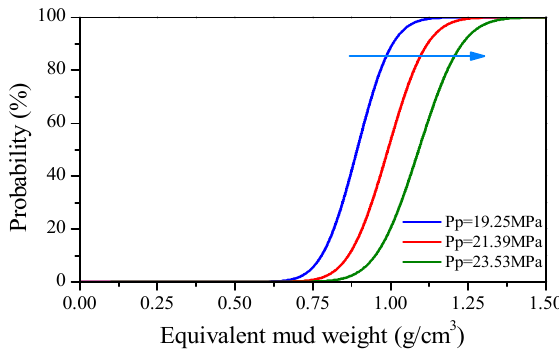
Figure 18. Influence of mean value of pore pressure on cumulative probability for EMWPP.